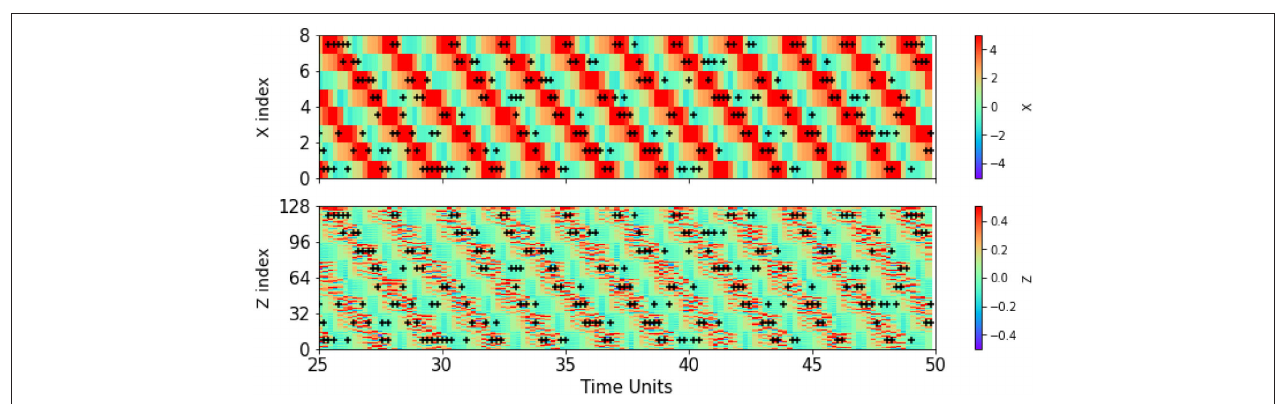
FIGURE 4 | Locations of the adaptive observations for PE with the true states of the resolved X variables (A) and unresolved Z variables (B) .